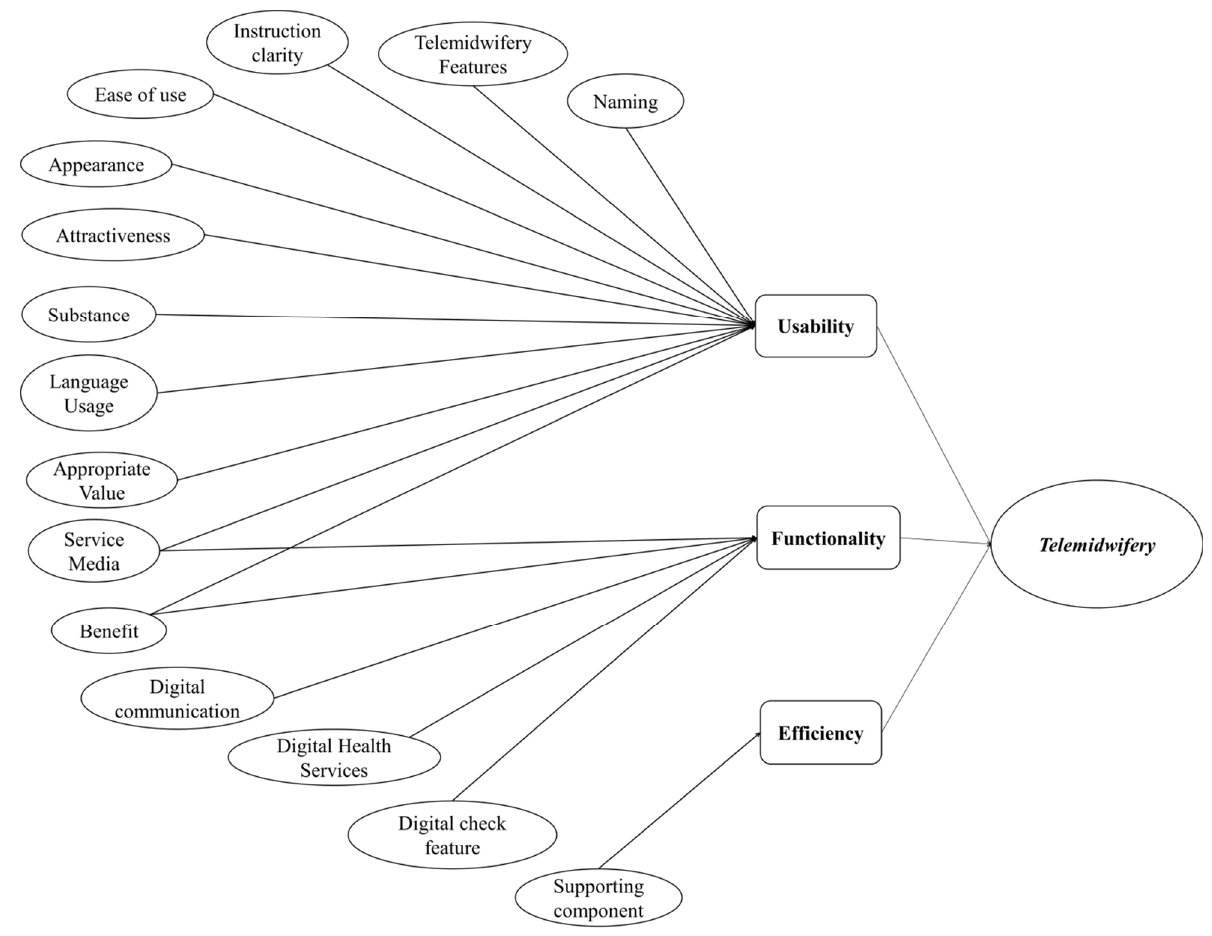
Figure 3. Telemidwifery Menu Content Concept.